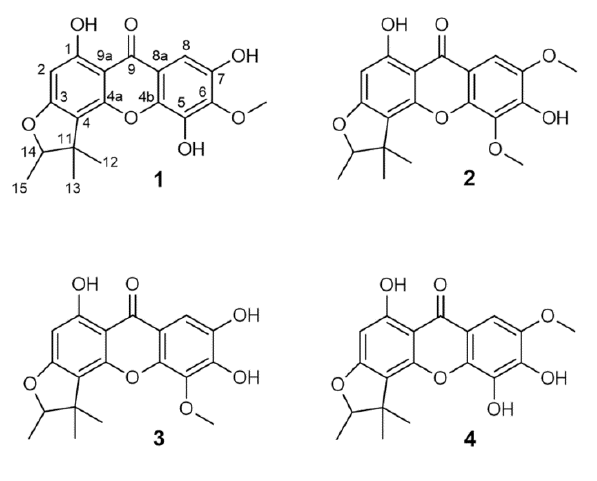
Figure 1. Chemical structures of the identified xanthones.